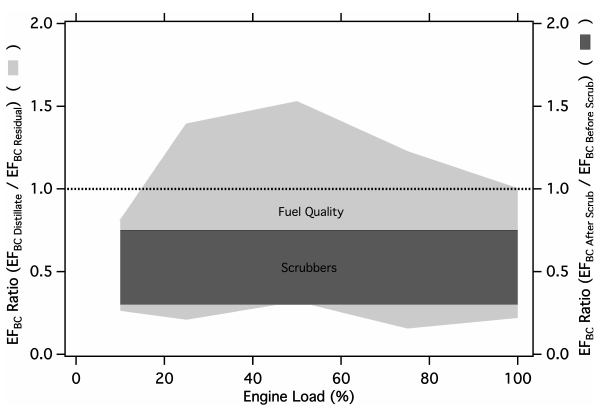
Fig. 8. Comparison of the range of EF BC changes due to fuel quality improvement (grey) and exhaust scrubbing